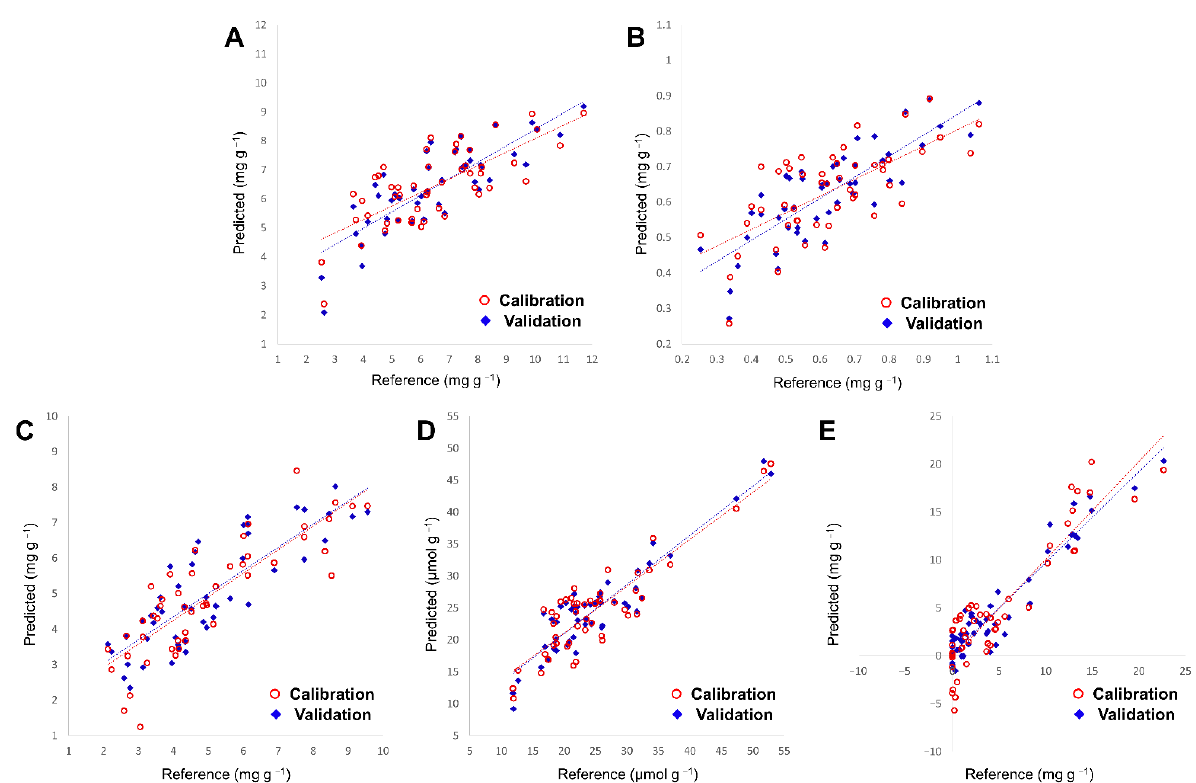
Figure 5. Prediction models for each functional component: ( A ) total chlorophylls, ( B ) total carotenoids, ( C ) total phenolics, and ( D ) total glucosinolates with the 8th pre-processing combination; ( E ) total anthocyanins with the 4th pre-processing combination. Fifth-five samples were used to establish each prediction model.